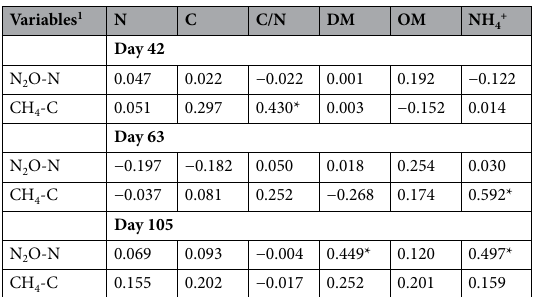
Table 5. Pearson’s correlation coefficients between explanatory variables on each sampling day. *Represents a statistical significance (P ≤ 0.05) for the coefficients of correlation. 1 DM = dry matter, OM = organic matter, NH 4+ = ammonium.